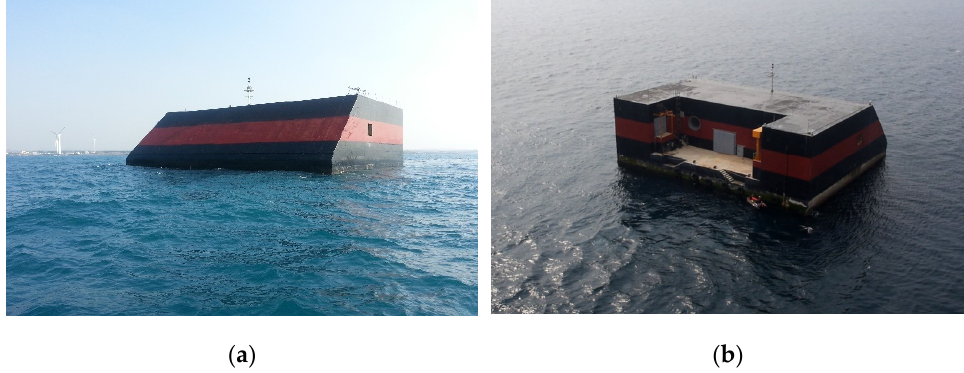
Figure 1. Oscillating water column wave energy structures (OWC): ( a ) Front (air chamber); ( b ) Rear (docking facility).